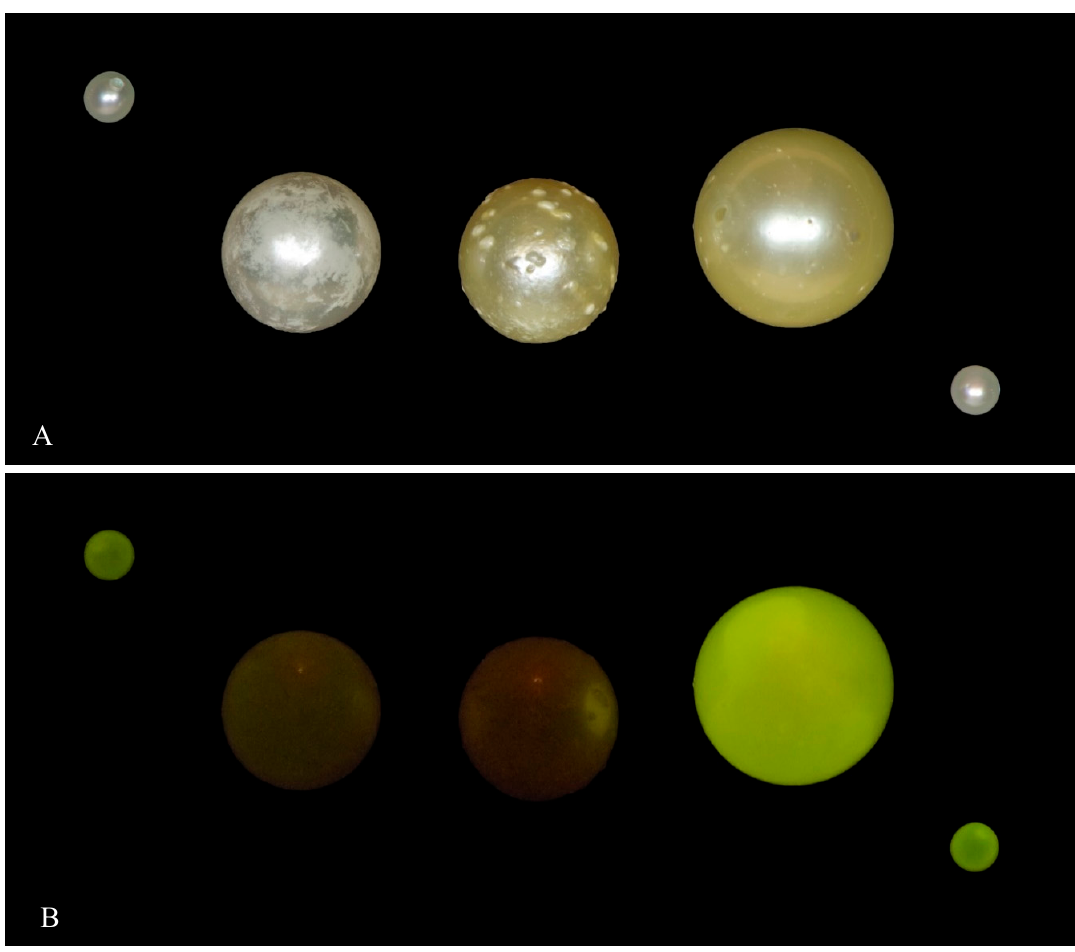
Figure 8. Saltwater cultured pearls (with freshwater bead) under daylight ( A ) and under X-rays ( B ). The first and second pearls from the left has a similar nacre thickness that equals 1.8 mm, while the third one has a nacre thickness of 0.65 mm (measured using X-ray microradiography). The two freshwater samples upper left (diameter: 2.85 mm) and bottom right (diameter: 2.95 mm) used as reference.